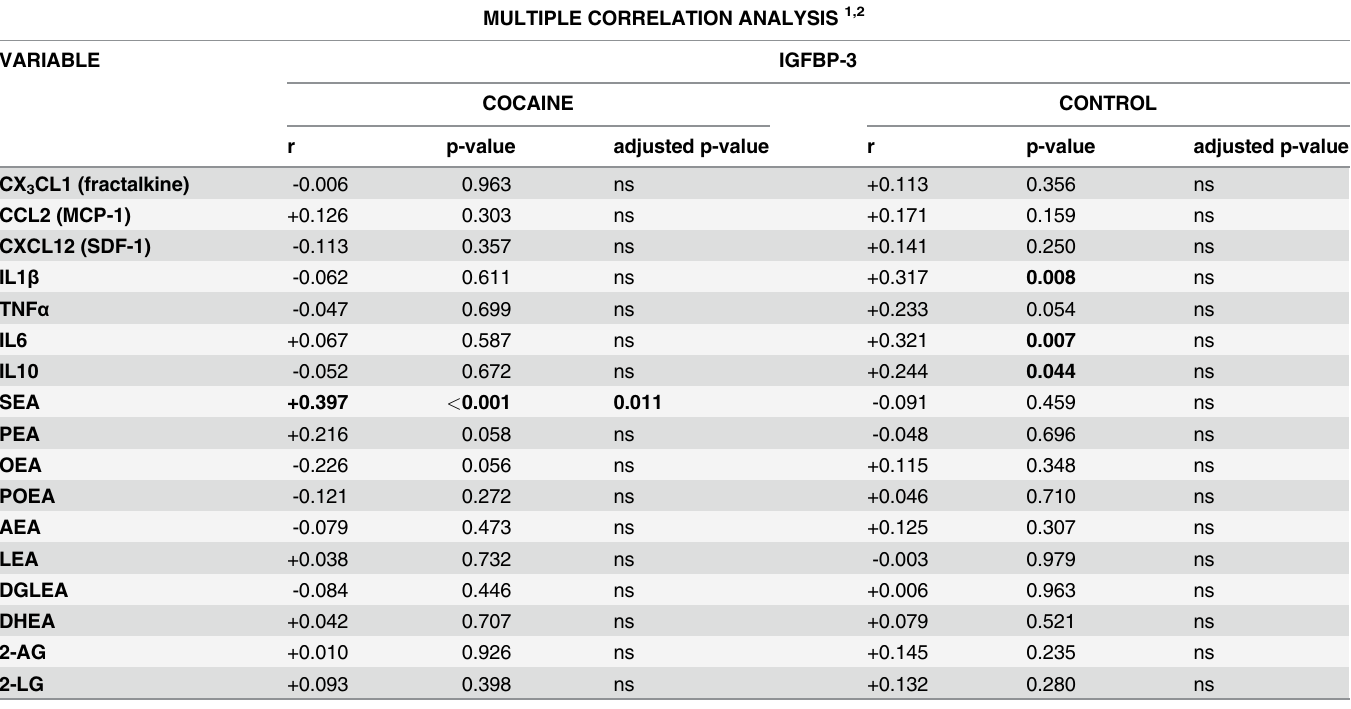
Table 4. Multiple correlations between plasma concentrations of IGFBP-3 and other plasma molecules in the cocaine